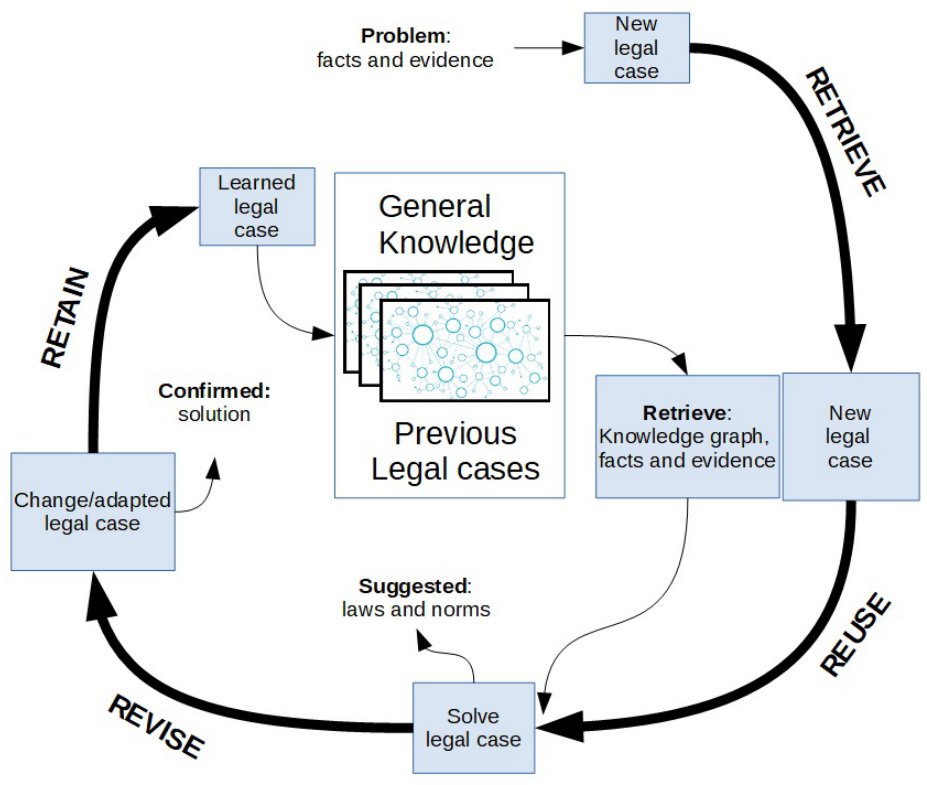
Figure 1. Stages of the case-based reasoning life-cycle, used in the RYEL system: Retrieve, reuse, review, and retain.